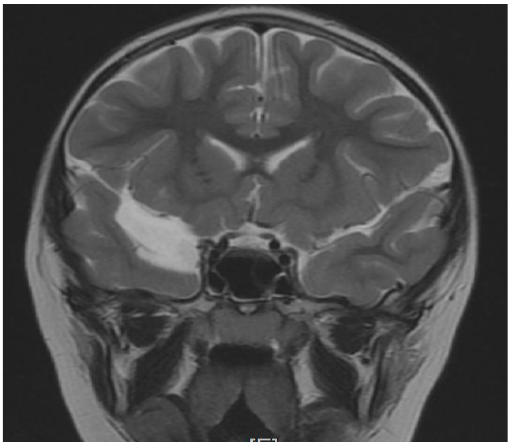
Figure 2. Coronal (T2-weighted sequence) — cyst — at the front of the temporal lobe.